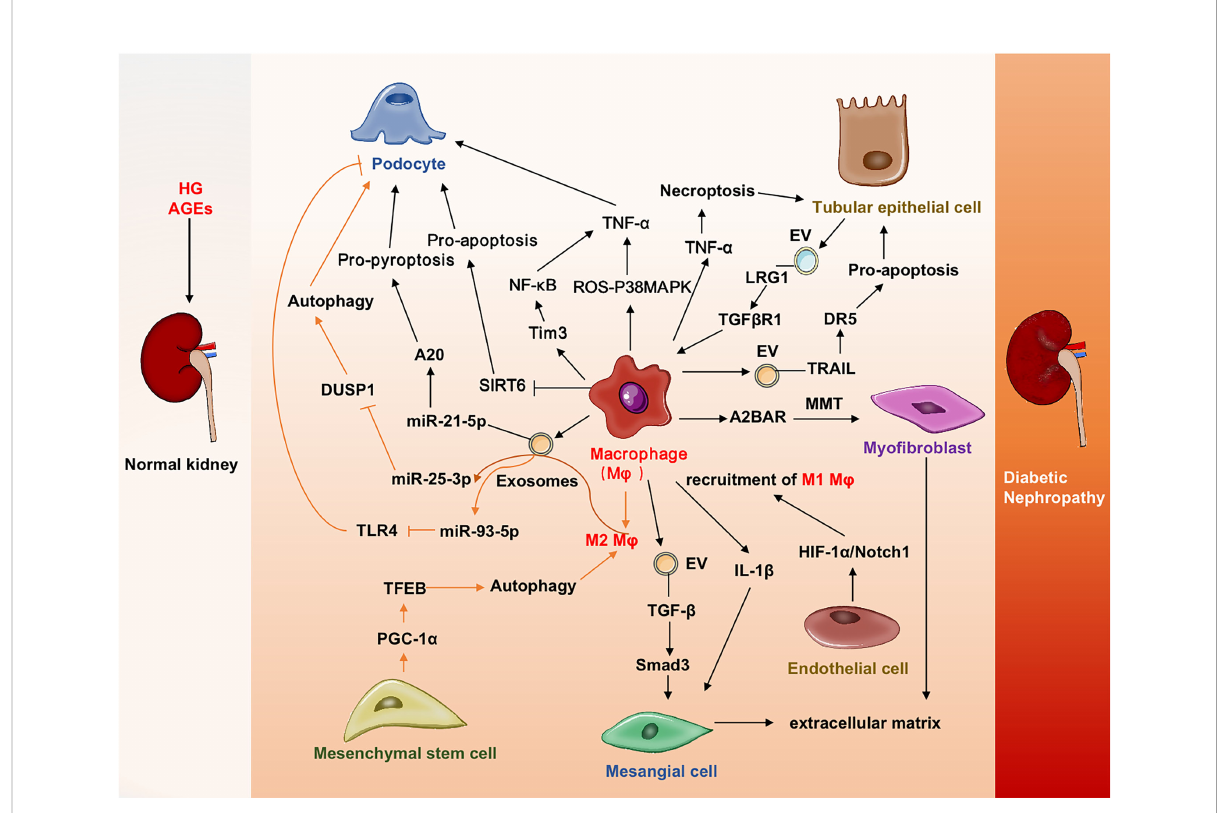
FIGURE 2 Cross-talks among macrophages and other cells in DN. Macrophages promote injuries or deaths of renal cells (podocytes, mesangial cells tubular epithelial cells, endothelial cells) by various mechanisms. Mesenchymal setem cells could promote macrophages transdifferentiated into myo fi broblast and contribute to tissue fi brosis. A2BAR, A2B adenosine receptor; DR5, Death receptor 5; DN, Diabetic nephropathy;DUSP1, Dual speci fi city protein phosphatase 1; EV, Extracellular vesicles; HIF-1 a , Hypoxia-inducible factor-1 a ; LRG1, Leucine-rich a -2-glycoprotein 1; MAPK, Mitogen-activated protein kinase; MMT, Macrophage-myo fi broblast transition; PGC-1 a , Peroxisome proliferator-activated receptor-gamma coactivator-1 a ; ROS, Reactive oxygen species; SIRT6, Sirtuin-6; TFEB, transcription factor EB; TGF b R1, TGF b receptor 1; Tim3, T cell immunoglobulin domain and mucin domain-3; TLR4, Toll-like receptor 4; TRAIL, Tumor necrosis factor-related apoptosis-inducing